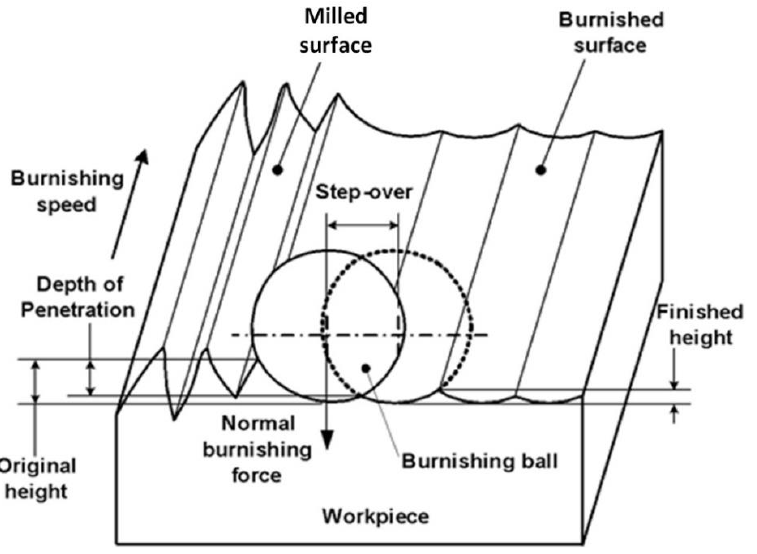
Figure 1 . Schematic of the small ball-burnishing process. Figure 1. Schematic of the small ball-burnishing